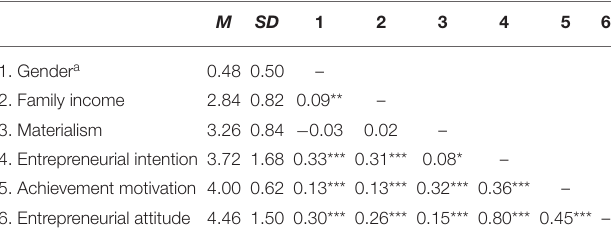
TABLE 3 | Descriptive statistics and zero-order correlations of